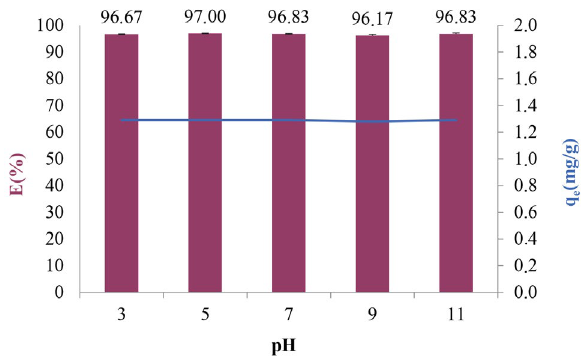
Figure 5. Effect of the pH of an aqueous medium, standard devia- tions calculated from measurements from nine parallel results, where E-efficiency of adsorption, q e -maximum adsorption capaci- ties at equilibrium (C i = 20 mg/L, 1.5 g, 160µm, 700 rpm, pH = 2-11, T = 20±1 o